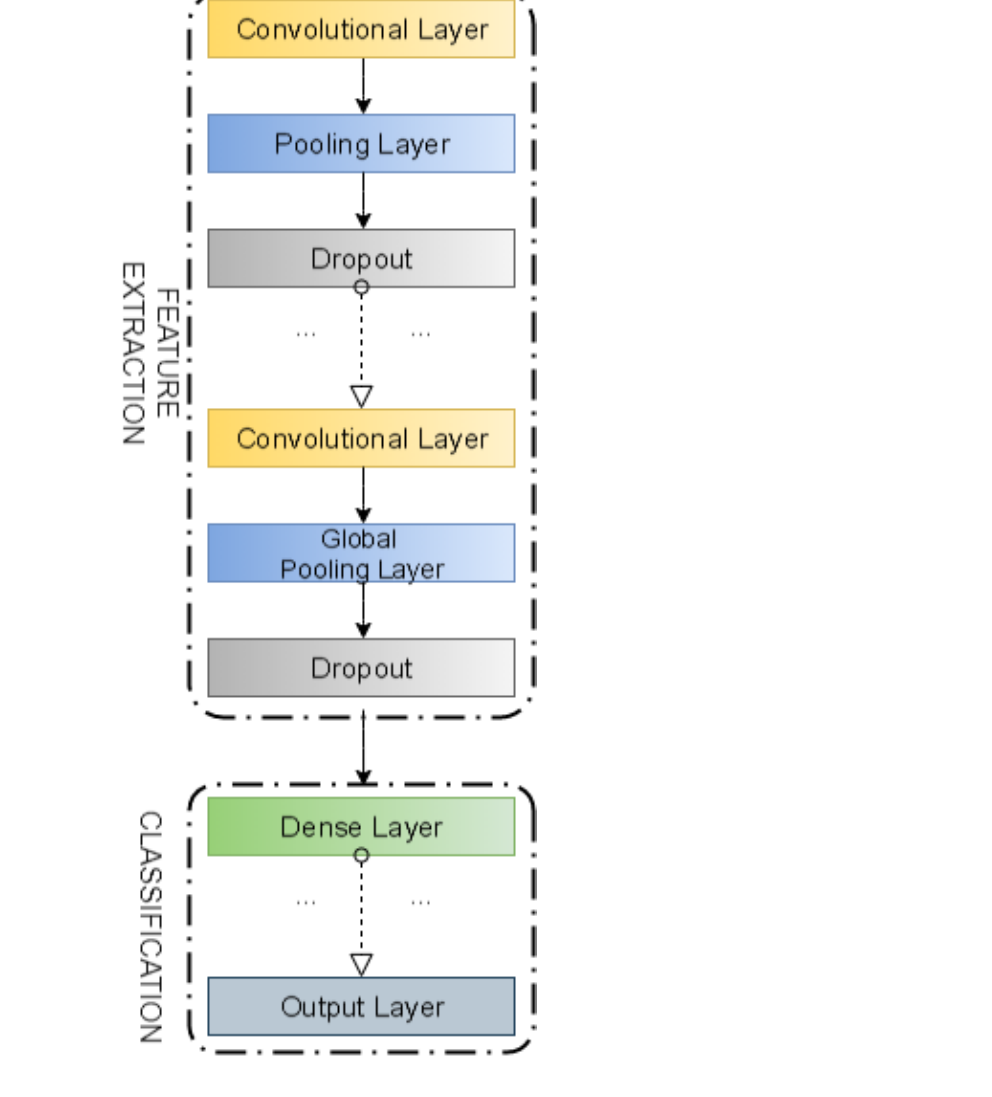
Figure 1. The conceptual structure of a Convolutional Neural Network based classifier used to model an Active Queue Management